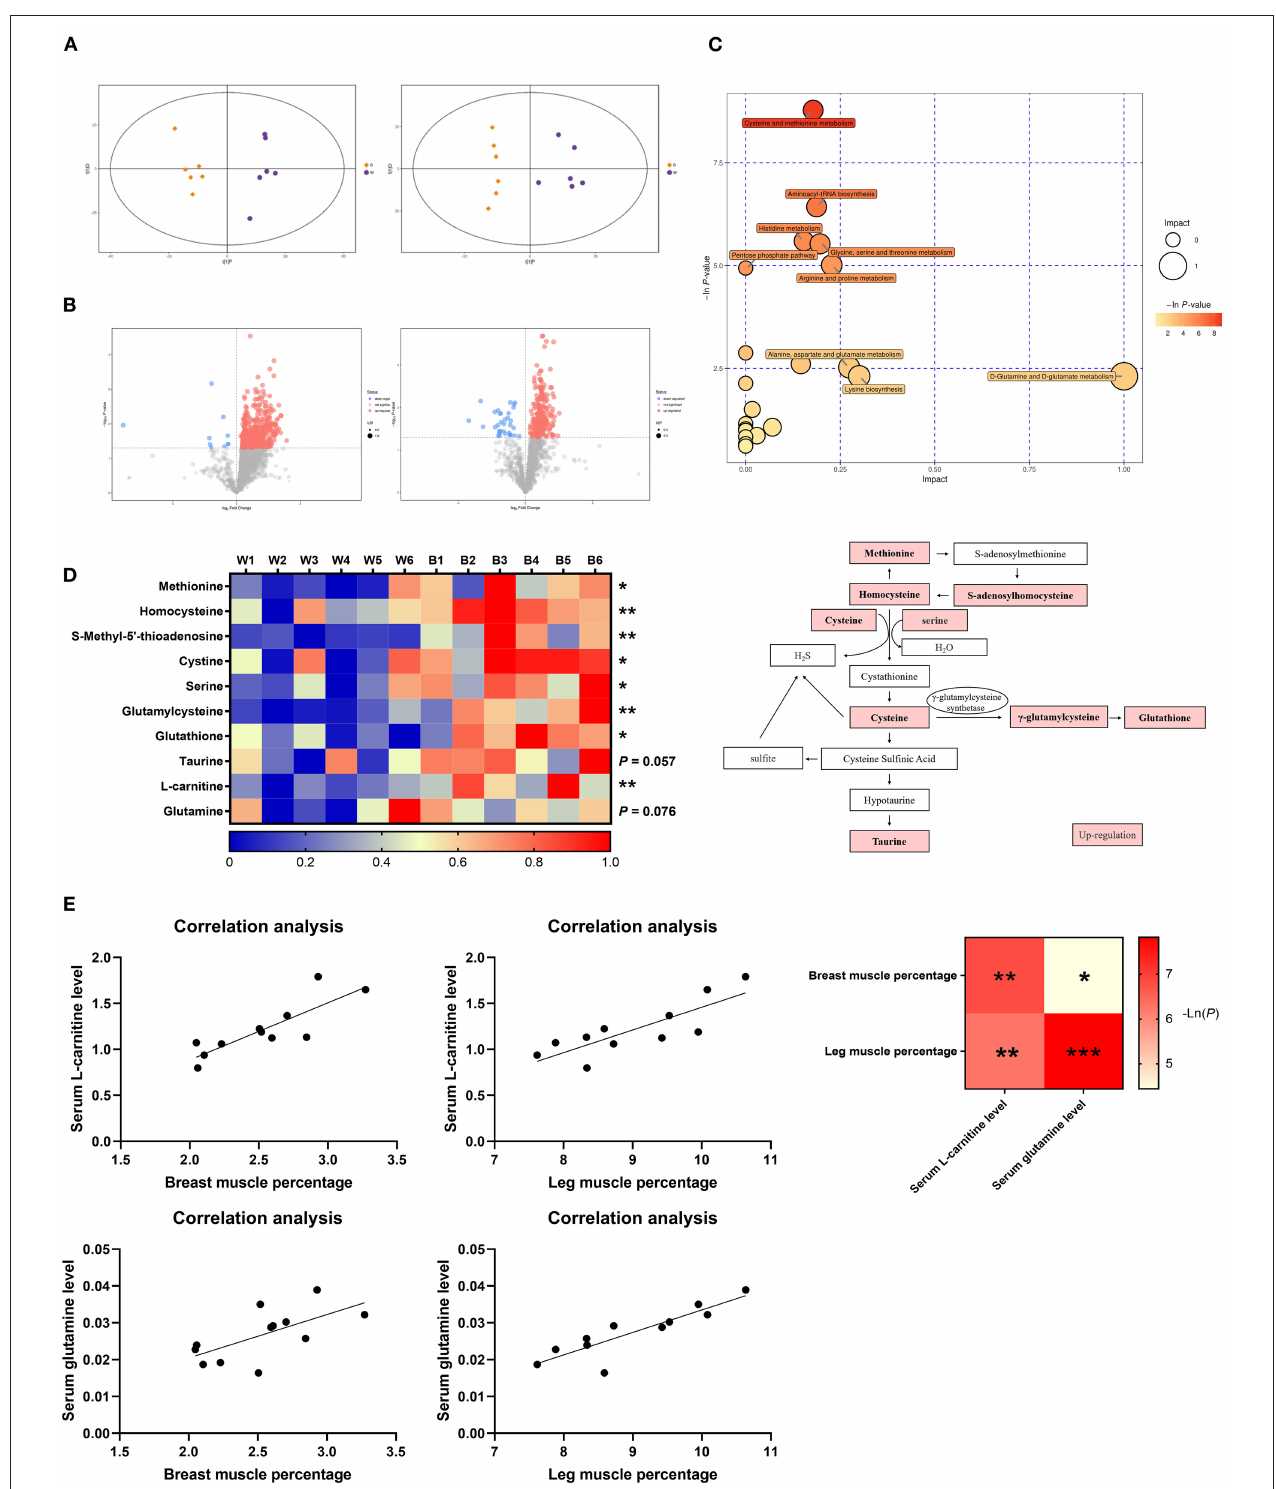
FIGURE 4 | Exposure to blue light improves glutathione and taurine levels in ducks by promoting methionine and cysteine metabolism. (A) OPLS-DA score plots of metabolomics ( n = 6). (B) Volcano plot representation of the differences in metabolites ( n = 6). (C) Metabolic pathway bubble chart ( n = 6). (D) Heatmap of LC-MS data showing metabolite changes after LED treatment with 460nm illumination ( n = 6). (E) Correlation analysis of the serum L-carnitine level and glutamine level with breast muscle percentage and leg muscle percentage. Increases in metabolite levels are shown in red. Data in d were analyzed using the unpaired t -test, * P < 0.05, ** P < 0.01. Data in (E) were analyzed using the computer non-parametric Spearman correlation *** P < 0.001.